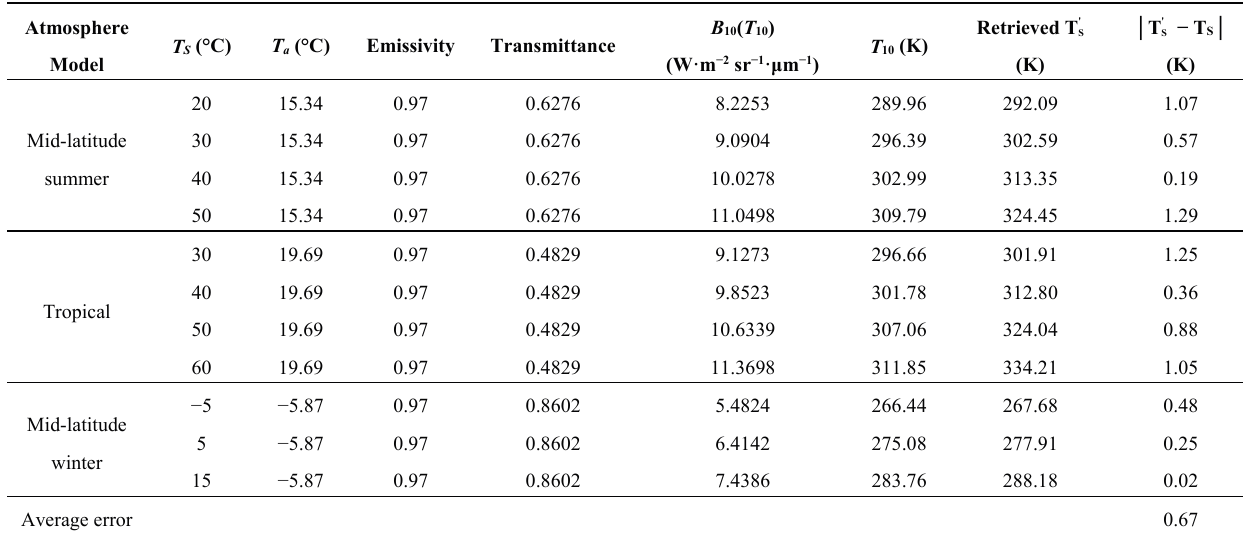
Table 10. Main results of testing the IMW algorithm for various situations.